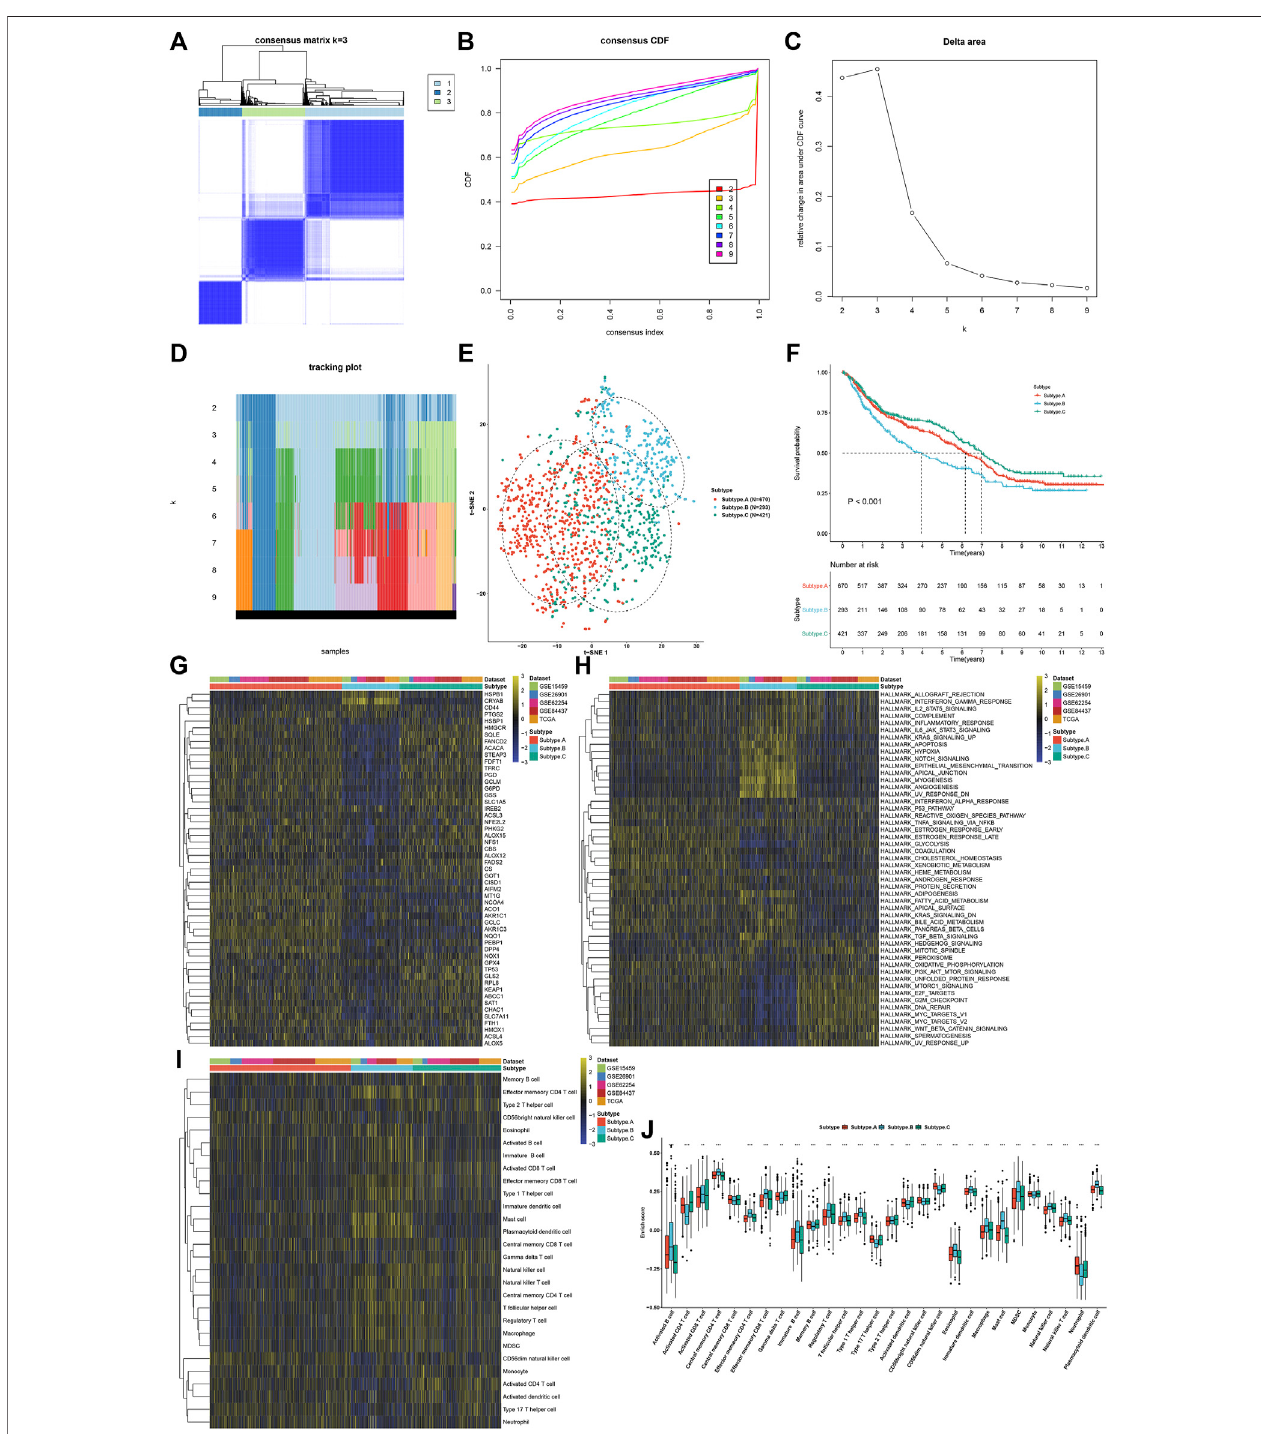
FIGURE 3 | Establishment of three ferroptosis regulator-mediated subtypes with different prognosis and TME immune in fi ltration in the GC meta-cohort. (A) Consensus matrix when k = 3. (B) Empirical CDF plots displaying the consensus distribution corresponding to each k. (C) Delta area diagram visualizing the relative change in area under CDF curve at different k. (D) Item tracking plot showing the consensus clustering of items (in column) at each k value (in row). (E) The t-SNE plots verifying the difference among three ferroptosis subtypes according to the mRNA expression of ferroptosis regulators. (F) Survival analysis for GC patients in three ferroptosis subtypes. (G) Heatmap showing the mRNA expression of ferroptosis regulators in three ferroptosis subtypes. Yellow, up-regulation; blue, down-regulation. (H) Heatmapfortheactivityofthe50hallmarkpathwaysinthreeferroptosissubtypes.Yellow,up-regulation;blue,down-regulation. (I) Heatmapvisualizingthein fi ltration levels of tumor-in fi ltrating immune cells in three ferroptosis subtypes. (J) Comparison of the in fi ltration levels of tumor-in fi ltrating immune cells in three ferroptosis subtypes. ** p < 0.01; *** p < 0.001.